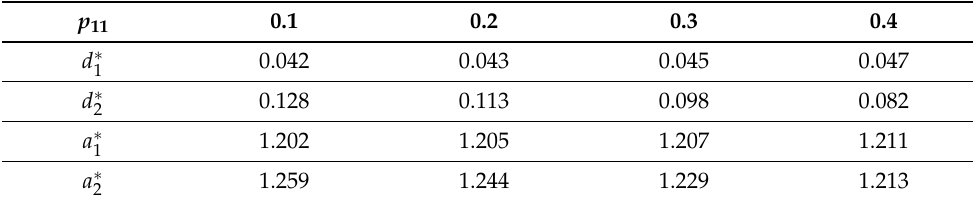
Table 3. Table 3. The effects of p 11